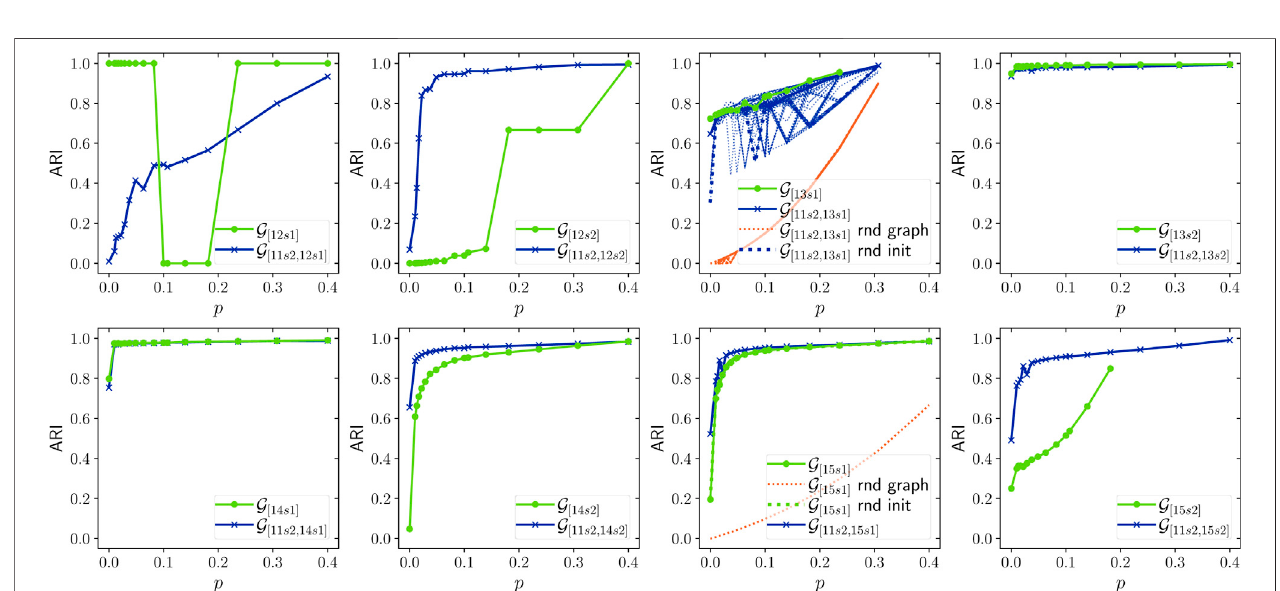
FIGURE 10 | ARI as a function of p